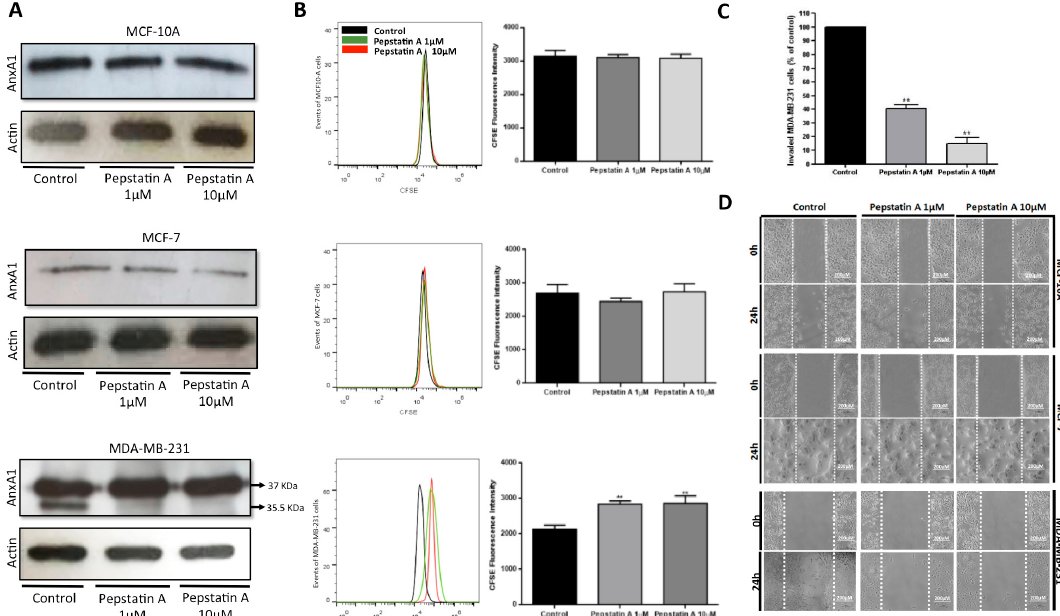
Figure 3. CatD inhibition by PepA impairs proliferation, migration, and invasion of MDA-MB-231. ( A ) Western blot analysis of AnxA1 expression of cells treated or not treated (control, vehicle only) for 24 h with 1 µ M and 10 µ M of PepA. Full-length AnxA1 (37 KDa) was detected in all cells and cleaved form (35.5 KDa) was detected only in MDA-MB-231 cells. Actin was used as loading control. ( B ) Proliferation analysis of MCF-10A, MCF-7, and MDA-MB-231 cells treated with PepA (1 µ M, grey peak; and 10 µ M, red peak) compared to control group (vehicle only, black peak) using CFSE staining. Respective bar graphs show the CFSE fluorescence intensity and statistical analysis of three independent experiments expressed as means ± SD (**, p < 0.01). ( C ) Percentage of invaded cells relative to control was measured by Matrigel invasion assay. Graph shows the percentage of invasion of three cell lines and statistical analysis of three independent experiments were expressed as means ± SD (**, p < 0.01). ( D ) Migration potential was assessed by wound-healing assay. Cells were plated, scratched with pipette tips, and photographed by phase-contrast microscopy. Representative images, showing cells migrated at 0 h and after 24 h. Scale bars = 200 µ